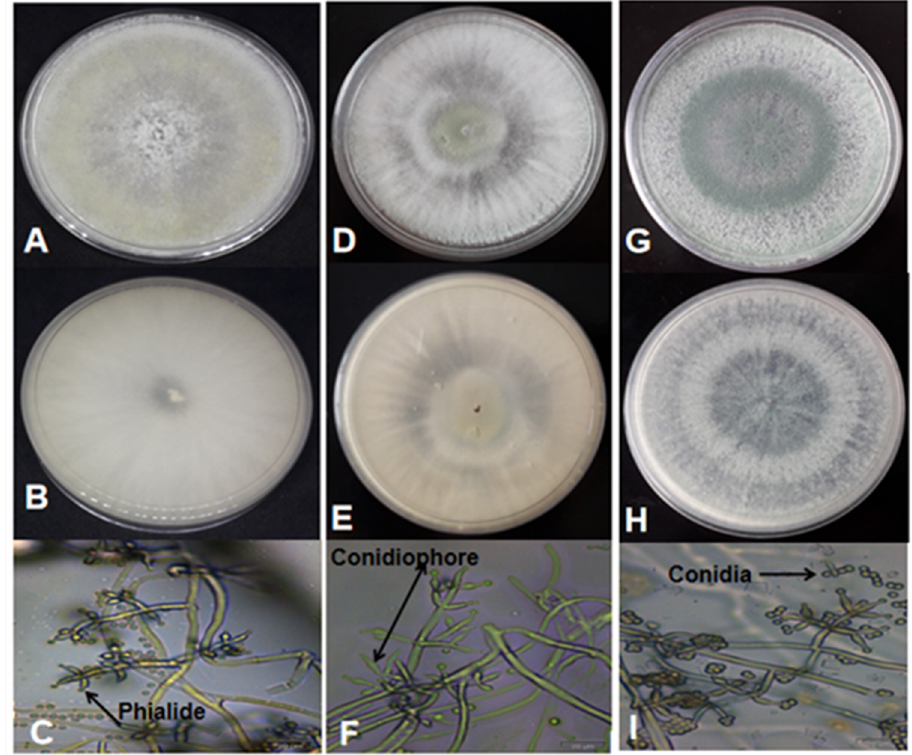
Figure 1. The morphological (macroscopic and microscopic) characteristics of three Trichoderma species: ( A , B ) Front colony and reverse of T. harzianum (TMS623); ( D , E ) the front colony and reverse of T. hamatum (TMS633); ( G , H ) the front colony and reverse of T. asperellum (TMS45). Colony characteristics were observed at 5 days incubation in SDAY at 28 °C; ( C , F , I ) The conidiophores with phialides and conidia of T. harzianum (TMS623), T. hamatum (TMS633), and T. asperellum (TMS45) , respectively, observed with 400× magnification.